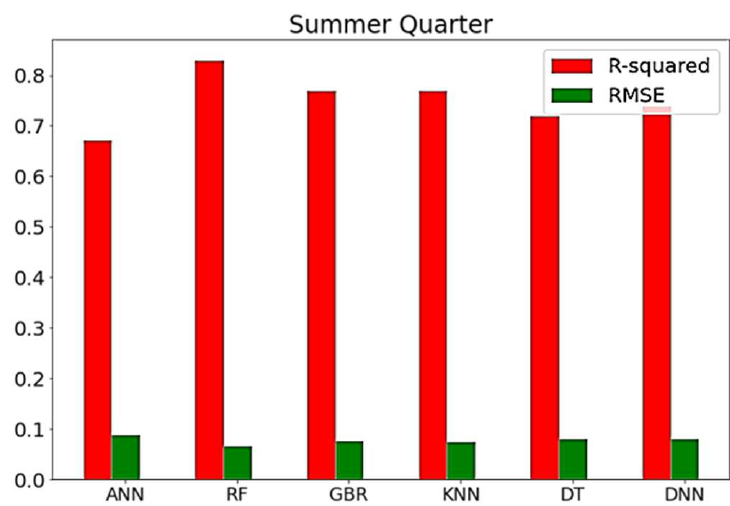
Figure 7. R 2 and RMSE metrics for the ML algorithms spring data set.